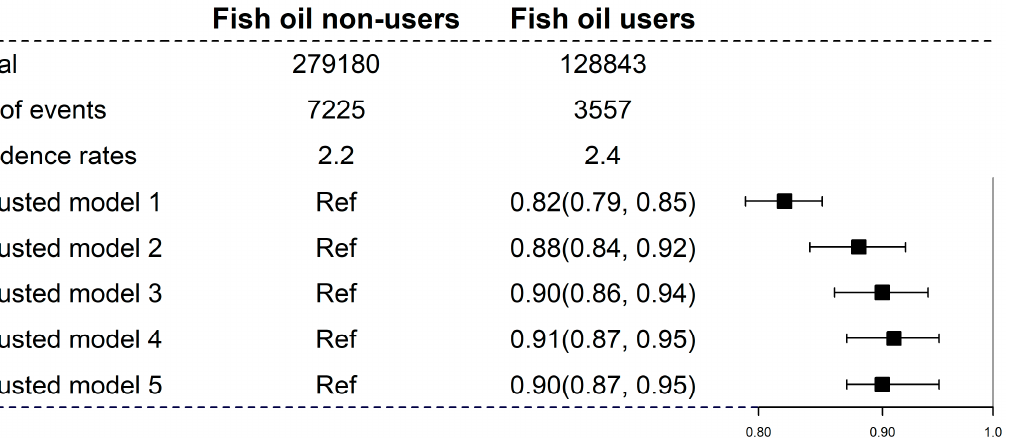
Figure 1. Relation of fish oil supplement with risk of incident chronic kidney disease. Incidence rates were expressed as per 1000 person – years, and “Ref” means the reference group with an HR of 1.00. Adjusted Model 1: Adjusted for age, and sex; Adjusted Model 2: adjusted for the covariates in Model 1 and further adjusted for race, Townsend Deprivation Index, body mass index, smoking status, alcohol consumption, diabetes, hypertension, high cholesterol, vitamin or mineral supplementation, and healthy diet score; Adjusted Model 3: adjusted for the covariates in Model 2 and further adjusted for renal function (estimated glomerular filtration rate, and urine albumin: creatinine ratio); Adjusted Model 4: adjusted for the covariates in Model 3 and further adjusted for oily fish and nonoily fish consumption; Adjusted Model 5: adjusted for the covariates in Model 4 and further adjusted for CKD genetic risk score.